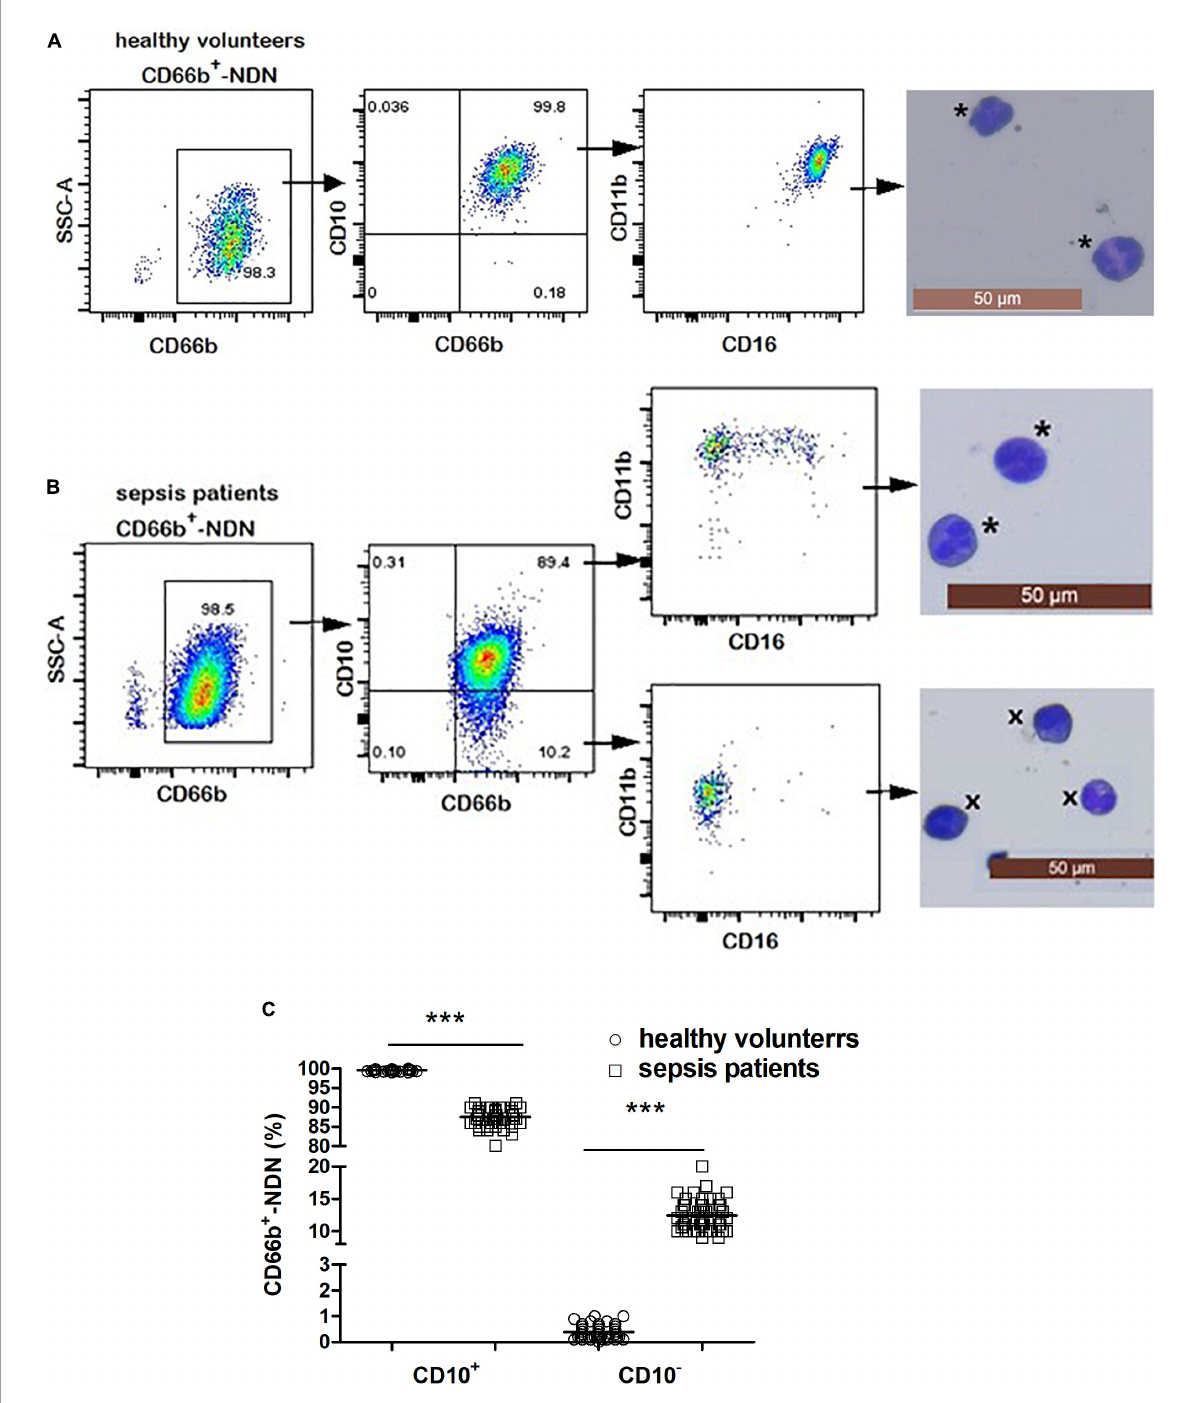
FIGURE4 (A) Flow cytometry and cytological morphology of CD66b + CD10 + -NDN in healthy volunteers. *Represents the mature neutrophils with a segmented nucleus typically characterized by of 2–5 lobes. (B) Flow cytometry and cytological morphology of CD66b + CD10 + / − -NDN in sepsis patients. *Represents the mature neutrophils with a segmented nucleus typically characterized by of 2–5 lobes; × represents bend cell which were similar with a characteristics horseshoe-shaped nucleus of uniform thickness. (C) The frequency of CD66b + CD10 + / − -NDN in healthy volunteers and sepsis patients. Significant difference existed between CD66b + CD10 + -NDN in healthy volunteers and sepsis patients, and CD66b + CD10 − -NDN in healthy volunteers and sepsis patients ( P < 0.001, respectively), *** P < 0.001 by Mann–Whitney U-